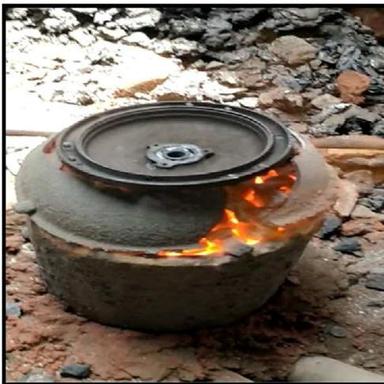
Crucible.